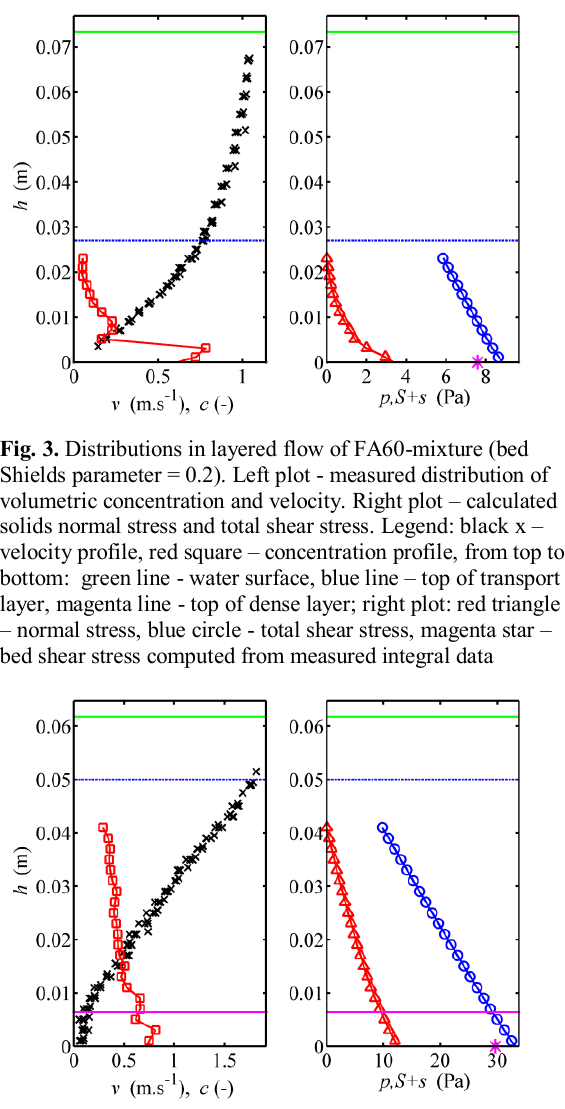
Fig. 4. Distributions in layered flow of FA60-mixture (bed Shields parameter = 1.1). Left plot - measured distribution of volumetric concentration and velocity. Right plot – calculated solids normal stress and total shear stress. Legend: black x – velocity profile, red square – concentration profile, from top to bottom: green line - water surface, blue line – top of transport layer, magenta line - top of dense layer; right plot: red triangle – normal stress, blue circle - total shear stress, magenta star – bed shear stress computed from measured integral data